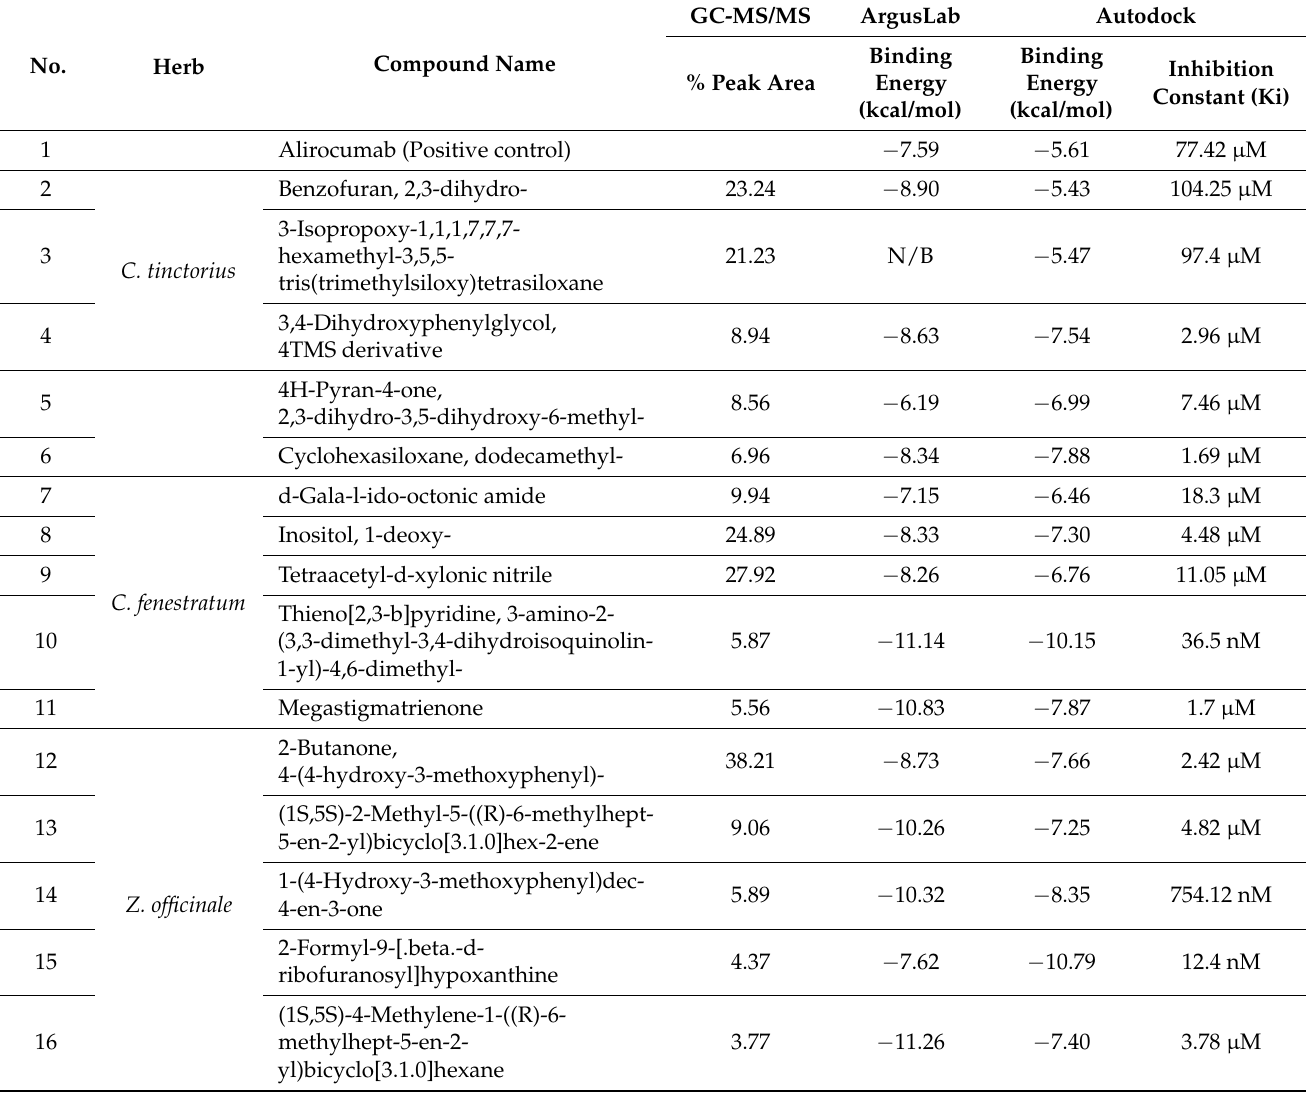
Table 11. Energy binding and phytochemical inhibition constants of herbal extracts with water at the binding sites of PCSK9 from ArgusLab and Autodock analysis and quantification of each compound through GC-MS/MS